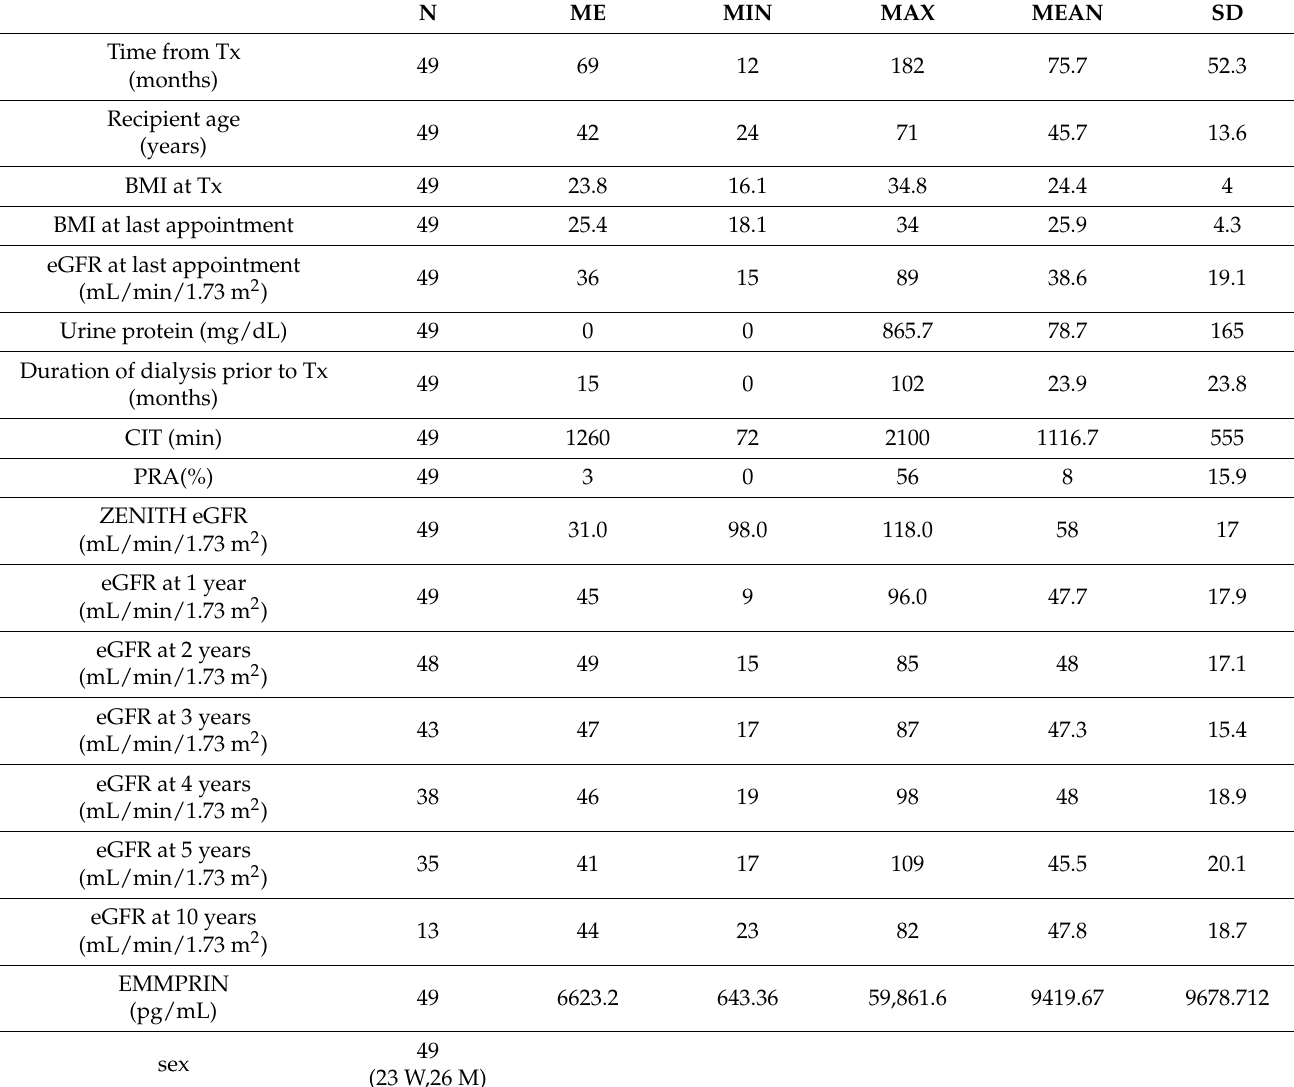
Table 2. Clinical characteristics of the study group.